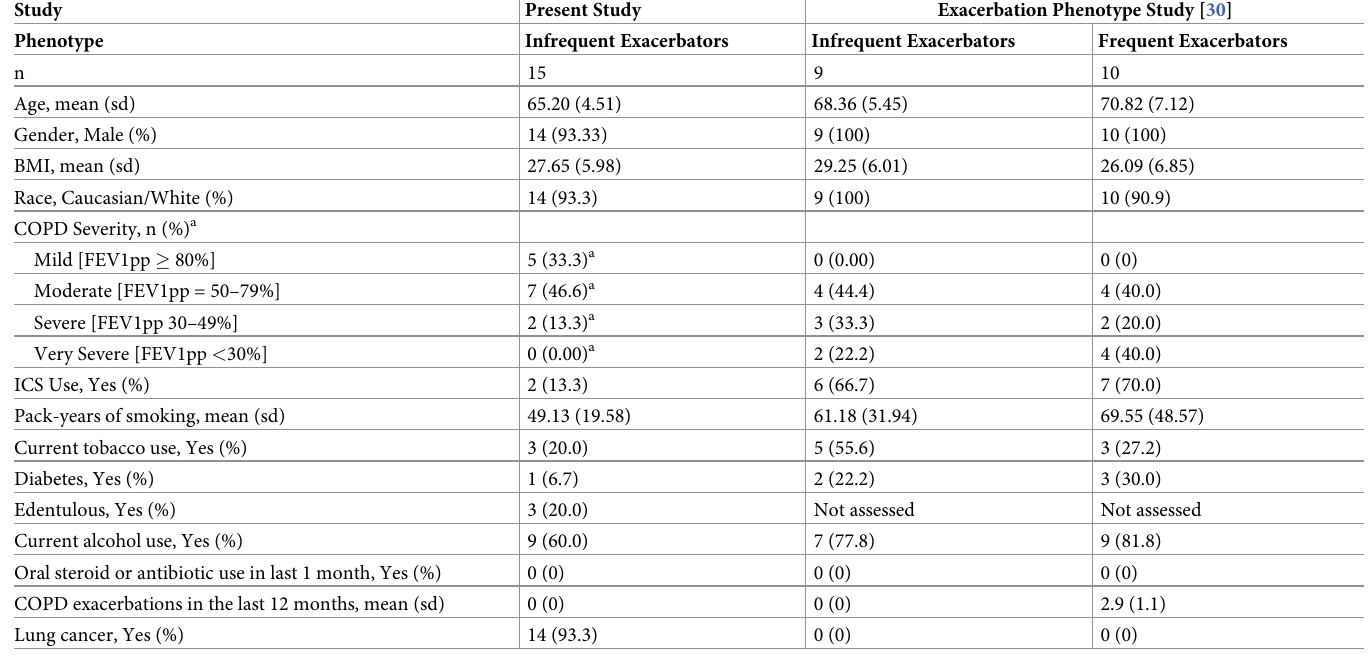
Table 6. Subject characteristics by